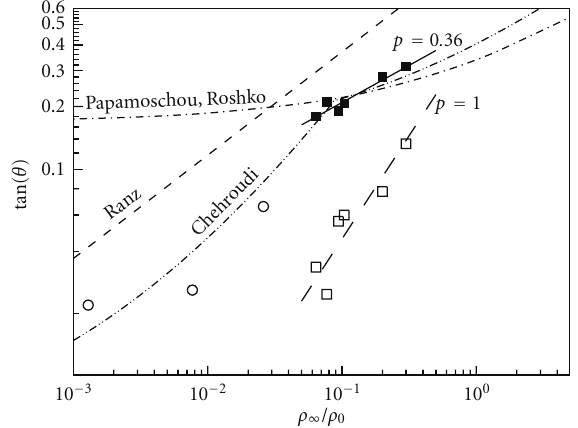
Figure 7: Comparison of the tangent of the spreading angle by Raman’s techniques using twice the FWHM values (DLR data). Solid squares are for data from x / D of 15 to 32 whereas hollow squares are from x / D of 0.5 to 14. Chehroudi’s model is also shown as dash-dot-dot curve. Single jet LN 2 into GN 2 with injector L/D = 11 . 6. Data from Oschwald and Micci [21]. Open circles are data points from Reitz and Bracco